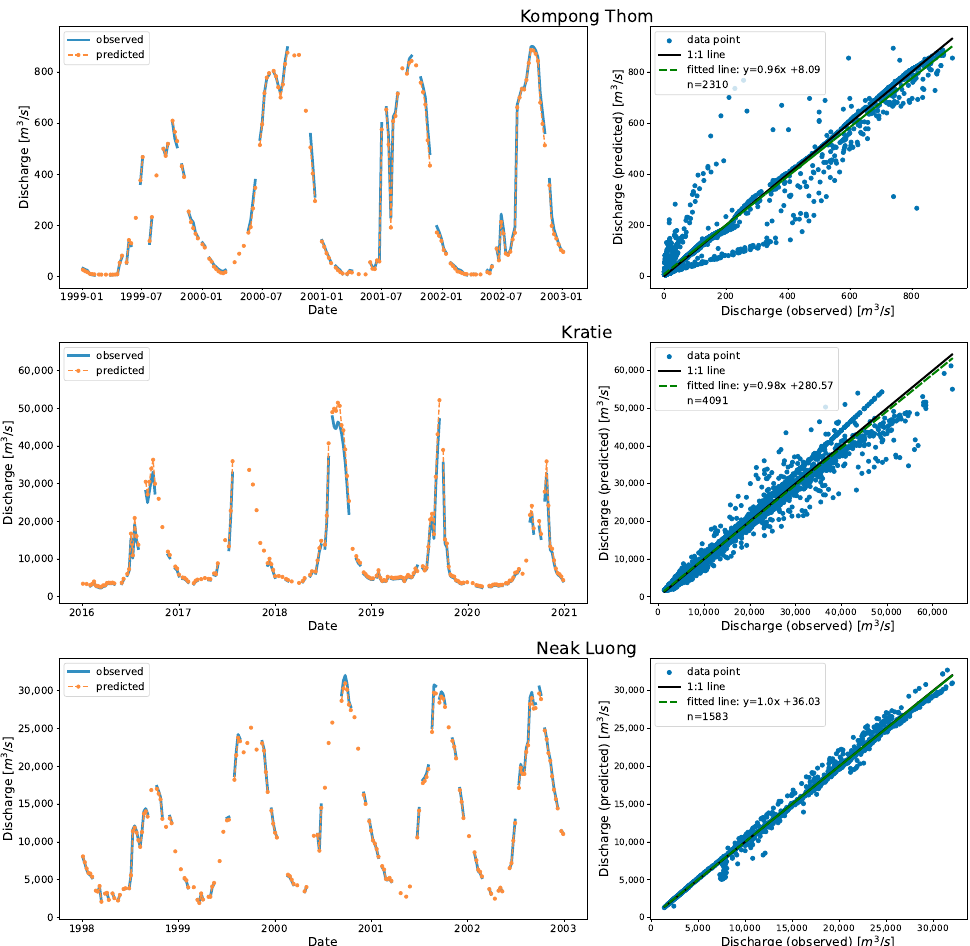
Figure 6. Predicted and observed discharge for Cambodia with fitted and 1:1 line. For visualization purposes, in the case of a time series plot ( left side ), the data are downsampled into a weekly bin, and the mean values of the discharge failing into the bins for the last five years for the station are shown while the scatter plot ( right side plot) shows all the validation data points. For Kompong Kdei, the upper flows of ∼ 175 m 3 /s visible in the scatter plot are from early years (not from the last five years as shown in the left plot) and can be seen in the full-time series plot available in Appendix A at Figure A1. The scatter plot at Kompong Thom, which had the highest RRMSE, shows that the prediction was poor at the low end compared to the high end. There is a data gap between the years 1970 and 1982 (Figure A1). The data gap could be due to Cambodia’s political instability because of Civil War [59,60]. Chaktomuk’s data appeared to have split into two ends at the high end. The model approximates the discharge by taking the values between two splits. The model at Neak Luong showed constant under prediction at low end before 1972 (Refer to Figure A1). The base flow of Neak Luong before 1972 has changed from that after 1980, which may be due to the massive flooding that occured in 1978 [61]. The clustering with time and stage as input features captured this variation. The model perfectly fits at Koh Khel (with KGE of 1.0). The station had a well-distributed dataset at low, mid, and high flow